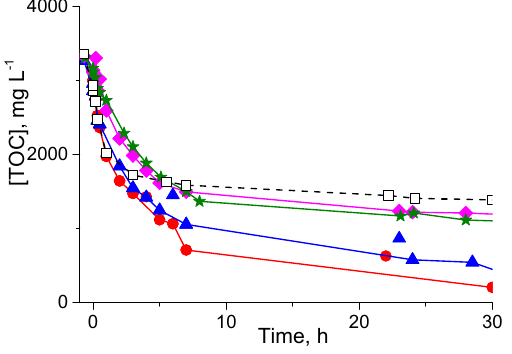
Figure 2. Evolution of: ( a ) Total Organic Carbon (TOC) and ( b ) concentrations of Total Nitrogen (TN) (measured by TOC-TN apparatus) and different N-species (analyzed by ionic chromatography) during oxidation of diluted VBC in the absence of a catalyst: TN ( ■ ), NH 4+ ( • ), NO 3- ( ), and NO 2- ( 7 ).